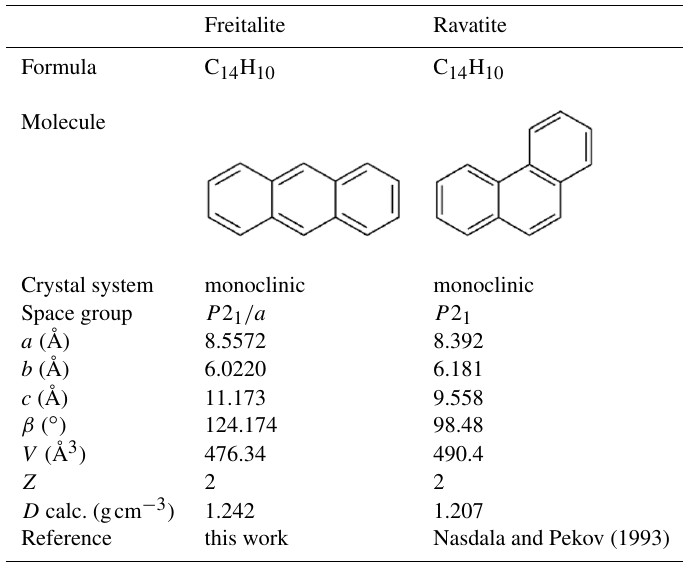
Figure 5. Rietveld refinement of the powder diffraction data of freitalite, using the structure data from Mason (1964). Atomic positions or occupation parameters were not refined. The hump in the scan is from the glass capillary. Glass contribution was modelled from an empty capillary. Table 3. Crystallographic data of freitalite and